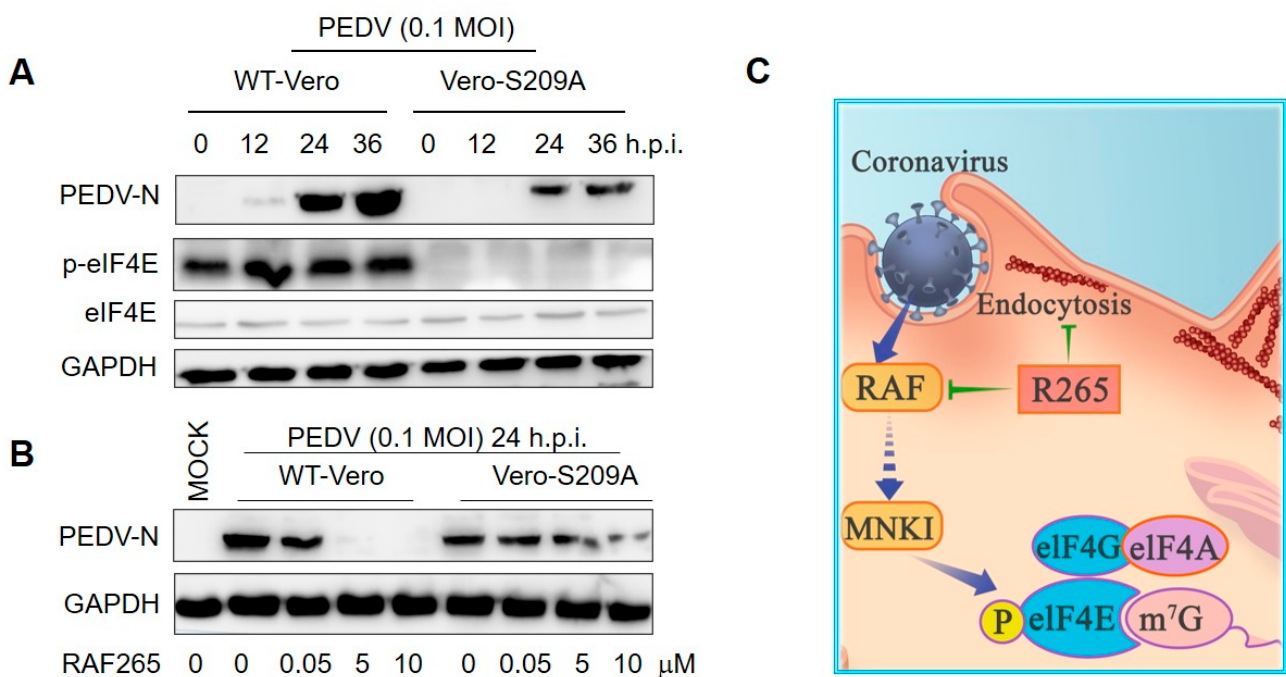
Figure 4. RAF265 suppressed the synthesis of viral proteins of PEDV. ( A ) Vero-WT and Vero-eIF4E (S209A) cells were challenged with PEDV for different times; cells lysates were harvested for WB analysis with indicated antibodies. ( B ) Vero-WT and Vero-eIF4E (S209A) cells were infected with PEDV in the presence of increasing doses of RAF265 for 24 h. Two cell lines were harvested for WB analysis with indicated antibodies. ( C ) Schematic representation of dual-targeting inhibitor RAF265 as active antiviral. After binding, PEDV enters into Vero cells by endocytosis, RAF265 mediates arrangement of actin cytoskeleton involved in the internalization of viral infection of PEDV. RAF265 also decreases the level of p-eIF4E to inhibit the synthesis of viral proteins. h.p.i, hours post-infection; MOI, multiplicity of infection.